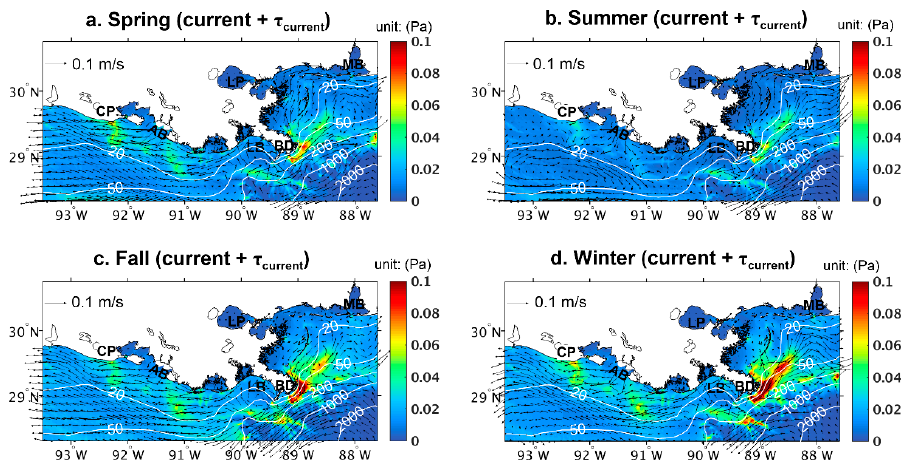
Figure 10. Depth-averaged current fields (arrow) and current-induced bottom shear stress ( τ current ; color) in spring ( a ), summer ( b ), fall ( c ), and winter ( d ). (AB: Atchafalaya Bay; BD: Bird-Foot Delta; LP: Lake Pontchartrain; MB: Mobile Bay; LB: Louisiana Bight; CP: Chenier Plain).